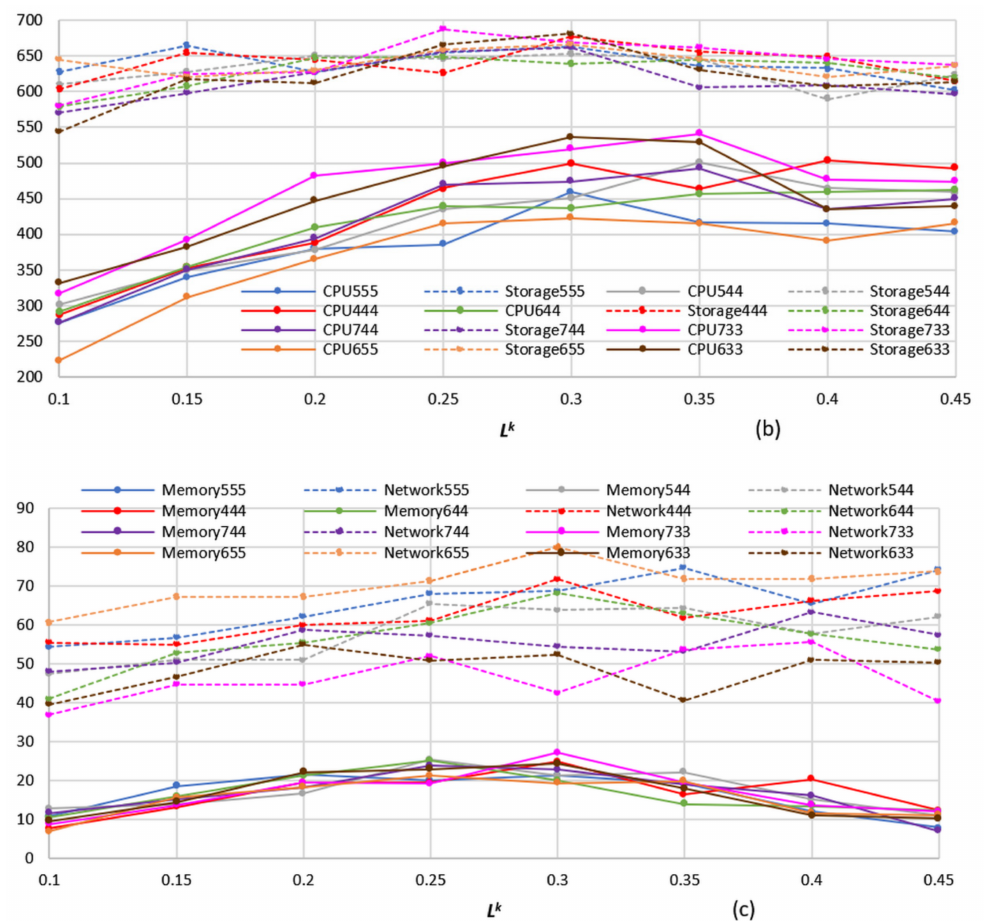
Figure 3. The influence of the variables L k , n , m , and l on the ( a ) the uptime of PMs and the number of VM migrations, ( b ) the number of CPU and Storage SLA violations, ( c ) the number of network and memory SLA